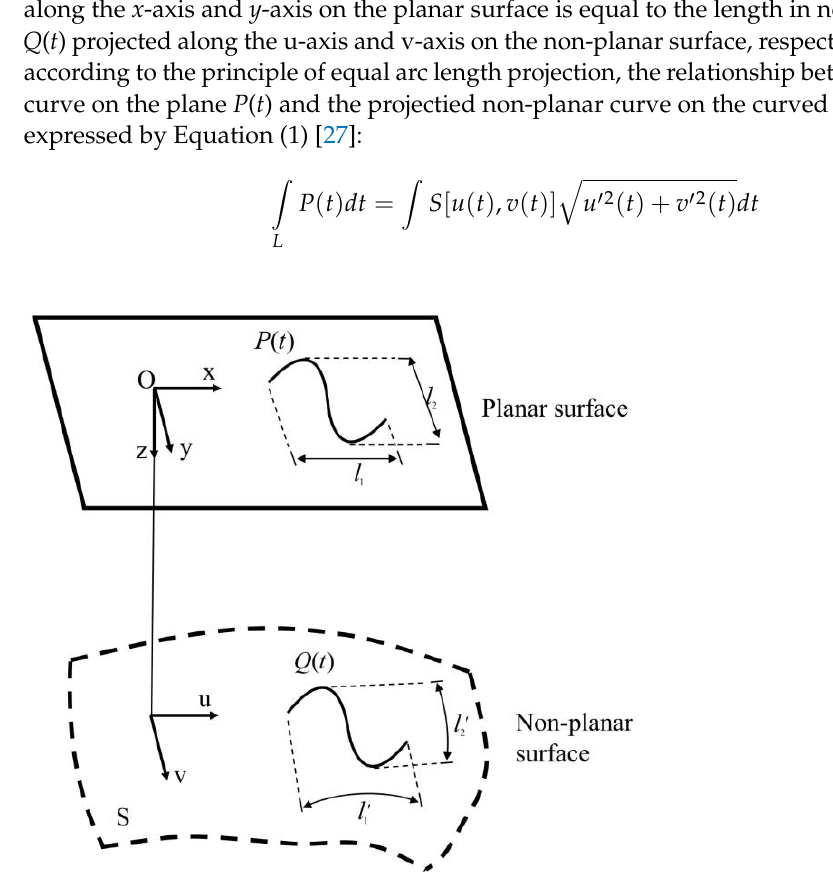
Figure 3. Schematic diagram of equal arc length projection of planar surface curve on non-planar surface.